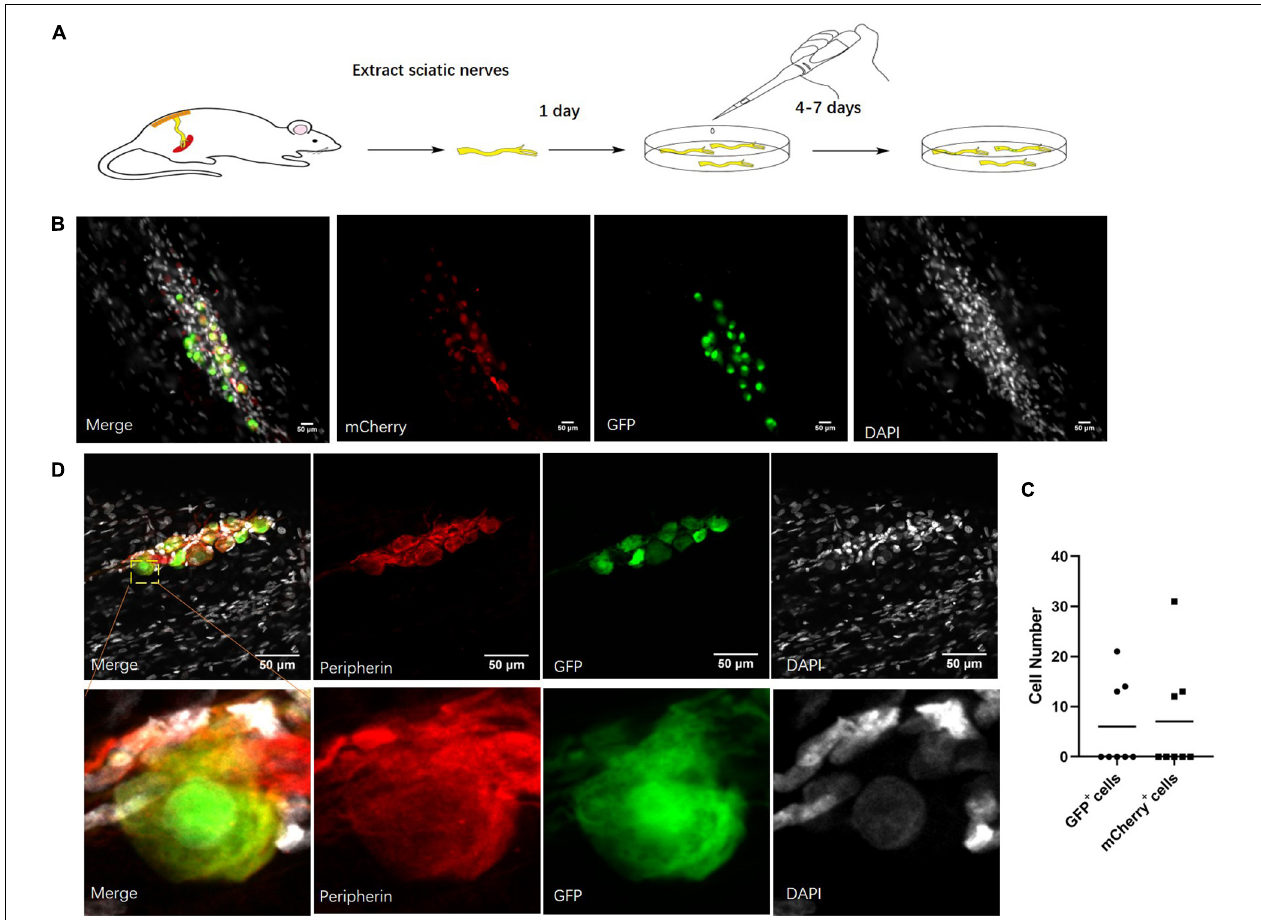
FIGURE 3 | Neuronal cells marked by virus in cultured sciatic nerves. (A) Sciatic nerve culture model. The sciatic nerves of adult rats were cultured in a defined serum-free medium. n = 8 (totally). (B) Cultured sciatic nerves infected by CMV -promoter mCherry AAV2/9 virus and hSYN -promoter GFP AAV2/9 virus for 2 weeks. Distribution of CMV -promoter GFP + cells (green) and hSYN -promoter mCherry + cells (red) in the cultured sciatic nerves. n = 3 (sciatic nerves with GFP + mCherry + cells). Scale bar, 50 µ m. (C) The quantification of GFP + cells and mCherry + cell number in the cultured sciatic nerves which were infected by CMV -promoter mCherry AAV2/9 virus and hSYN -promoter GFP AAV2/9 virus. The circle points represented the number of GFP + cells. The triangular points represented the number of mCherry + cells ( n = 3 of 8 which contain the GFP + mCherry + cells). (D) Virus-labeled cells are neuronal cells. Immunofluorescence staining for Peripherin (red) and DAPI (gray) was performed in cultured adult rat sciatic nerves with GFP (green)-labeled cells after 2 weeks infection of the hSYN -promoter GFP AAV2/9 virus. n = 4 (all the GFP + cells could be stained by Peripherin ). Scale bar, 50 µ